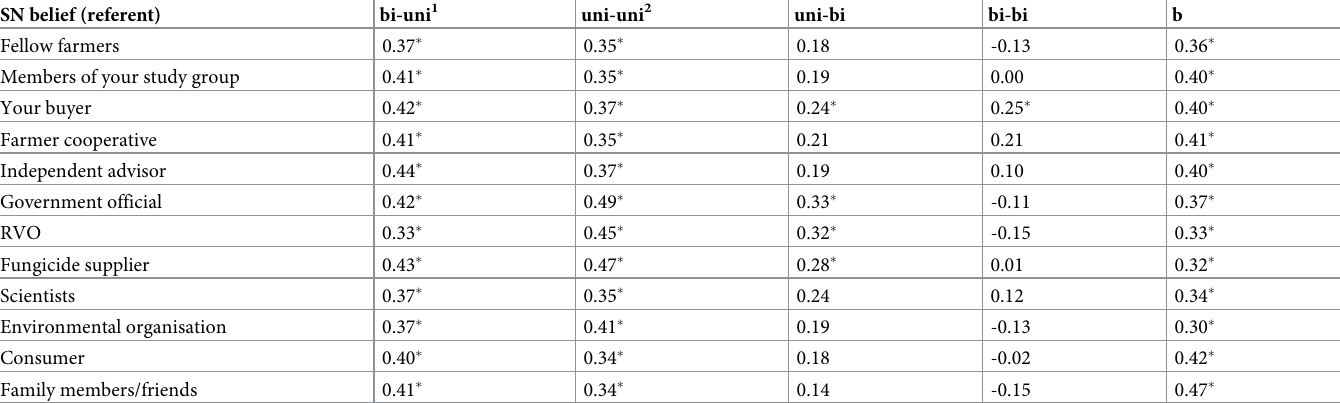
Table 8. Correlation coefficients between the SN belief score (b) and the SN construct, and between the four SN multiplicative composites (bi-uni, uni-uni, uni-bi, bi-bi), and the SN construct. SN belief